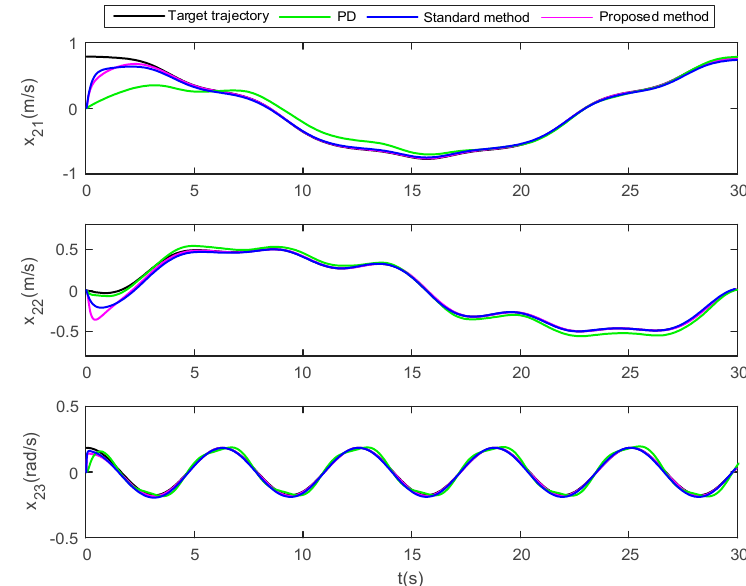
J. Mar. Sci. Eng. 2021 , 9 , x FOR PEER REVIEW Figure 6. Velocity tracking of the vessel under three control methods. Figure 6. Velocity tracking of the vessel under three control methods.